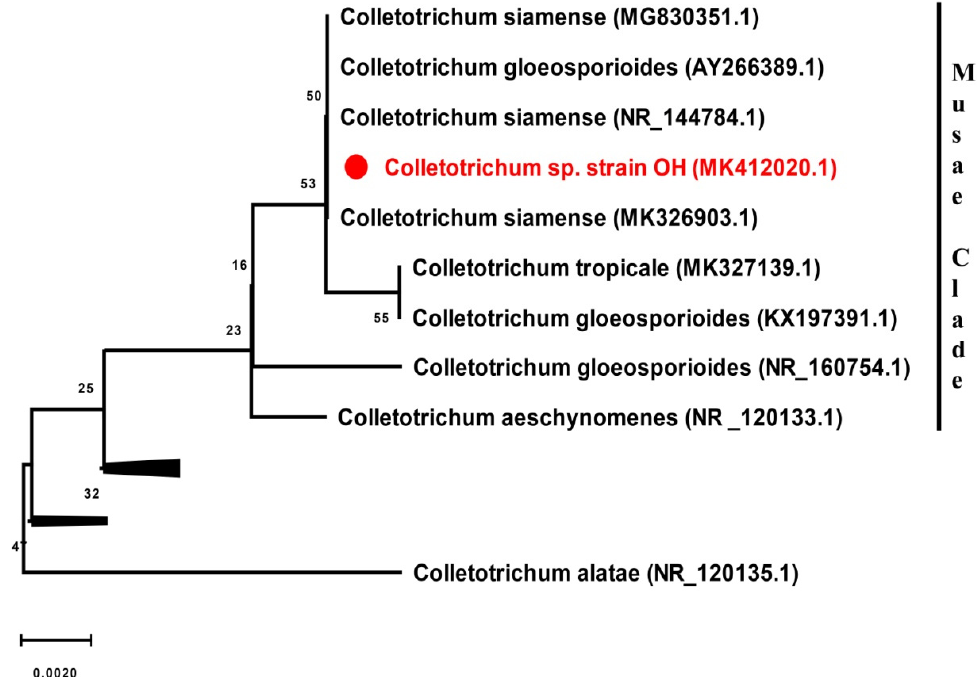
Figure 2. Rooted maximum likelihood phylogenetic tree using ITS gene sequences. The phylogenetic tree depicts Colletotrichum sp. strain OH (red filled circle and red text) with Musae clade of Colletotrichum gloeosporioides species complex. Accession numbers are in parentheses; Bootstrap values (based on 1000 replications) are shown at the branch points. Scale bar = 0.0020 substitutions per nucleotide position. A compressed tree is presented for clarity, and the complete tree is presented in Figure S1.